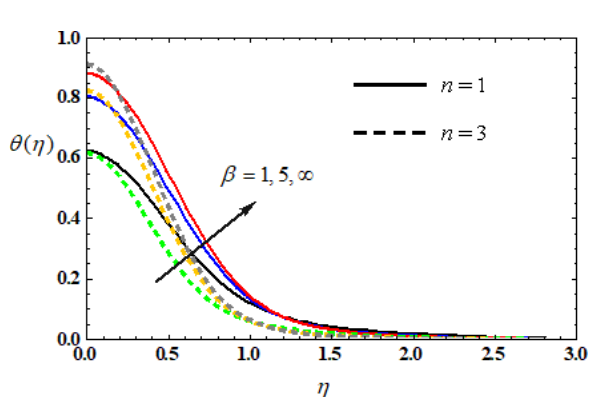
Fig. 4: Influence of β on θ ( η